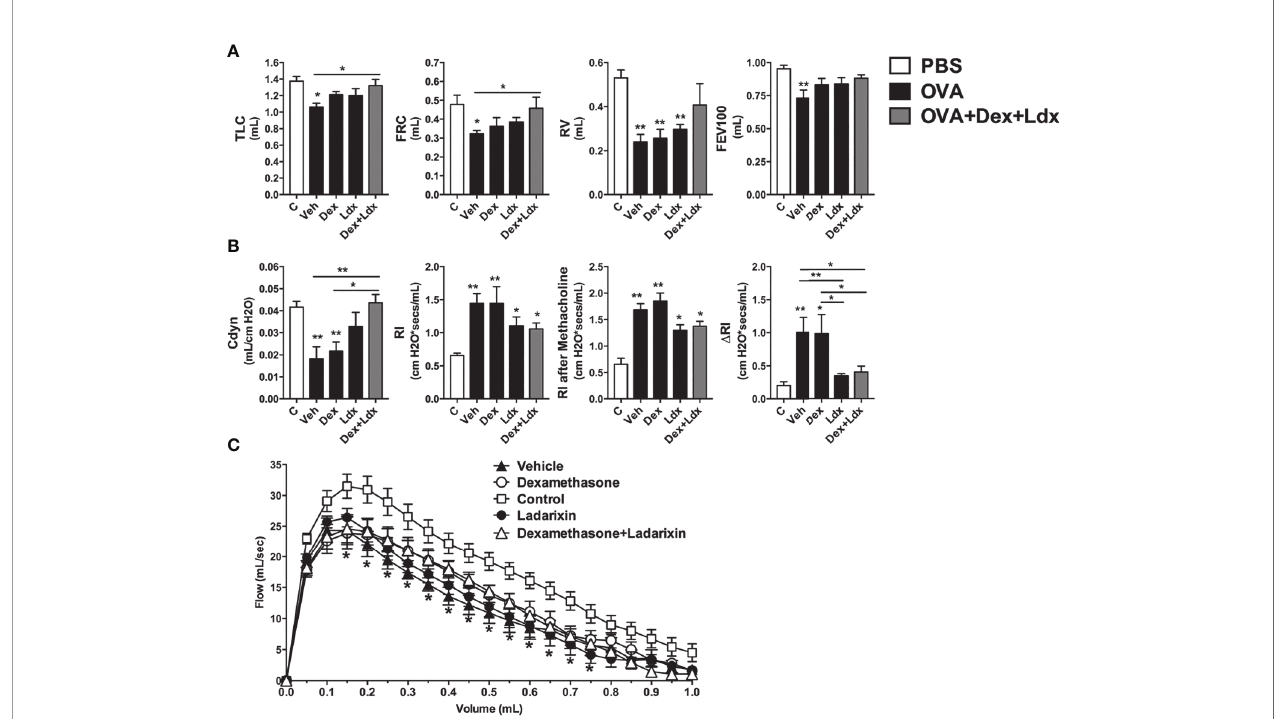
FIGURE 9 | Ladarixin treatment ameliorates pulmonary function in a Th1/Th17 GC-refractory neutrophilic asthma model. In fl ammatory parameters were evaluated after four daily challenges with OVA. (A) Lung volumes. (B) compliance and lung resistance. (C) Flow-volume curve. n = 8 for each group, * for P < 0.05 and ** for P < 0.01. TLC, total lung capacity; RV, residual volume; FRC, functional residual capacity; FEV100, forced expiratory volume in 100 ms; Cdyn, dynamic compliance; Rl, lung resistance; D Rl, methacholine-evoked